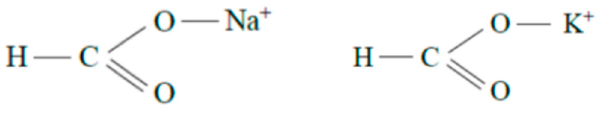
Figure 2. Sodium formate and potassium formate .